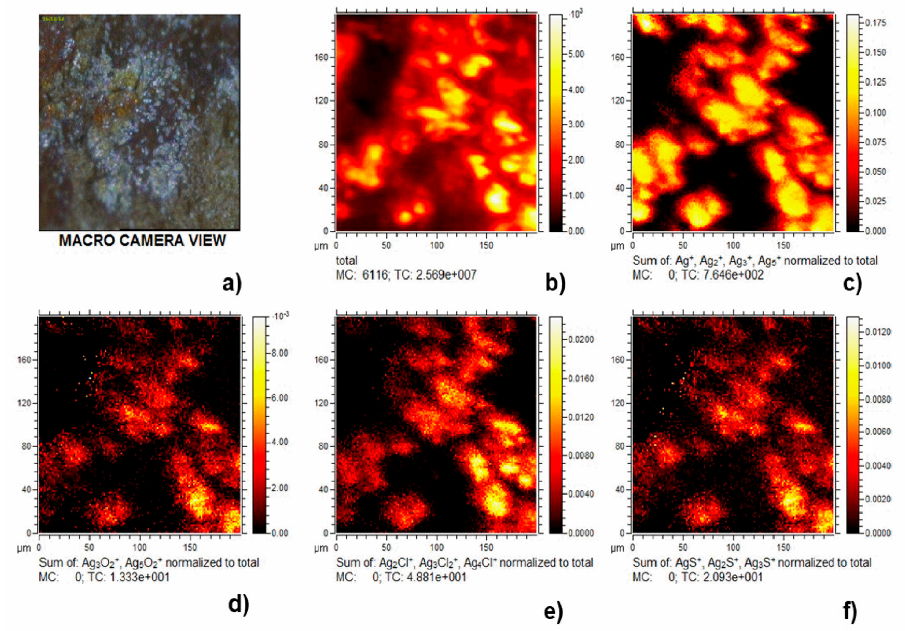
Figure 2. Silver-containing compounds in the silver leaf. ( a ) Macro camera view of the area where ToF-SIMS images were acquired (area of 200 μ m × 200 μ m). ( b – f ) TOF-SIMS ion images were recorded in the positive ion mode, ( b ) total ion image, ( c ) ion image of the sum of silver ions (sum of: Ag + , m / z 107, Ag 2 + , m / z 214; Ag 3 + , m / z 321, Ag 5 + , m / z 534), ( d ) ion image of the sum of silver oxides (sum of: Ag 3 O 2 + , m / z 353; Ag 5 O 2 + , m / z 567), ( e ) ion image of the sum of silver chlorides (sum of: Ag 2 Cl + , m / z 249, Ag 3 Cl 2 + , m / z 391, Ag 4 Cl + , m / z 463), and ( f ) ion image of the sum of silver sulfides (AgS + , m / z 139, Ag 2 S + , m / z 246, Ag 3 S + , m / z